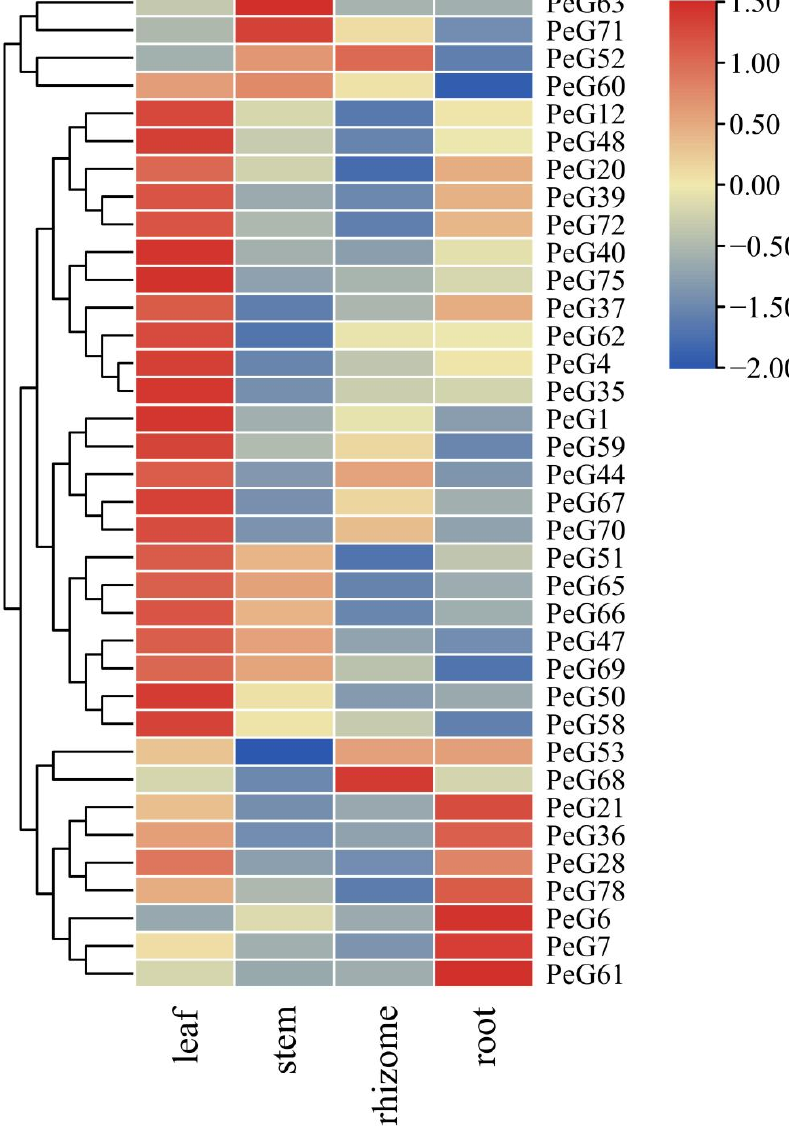
Figure 9. Expression profiles of PeGLK genes in different tissues. Samples were from leaf, steam, rhizome, and root. Expression level of each PeGLK gene can be estimated based on scale on right. Red, yellow and blue indicate high, medium and low levels of gene expression, respectively.